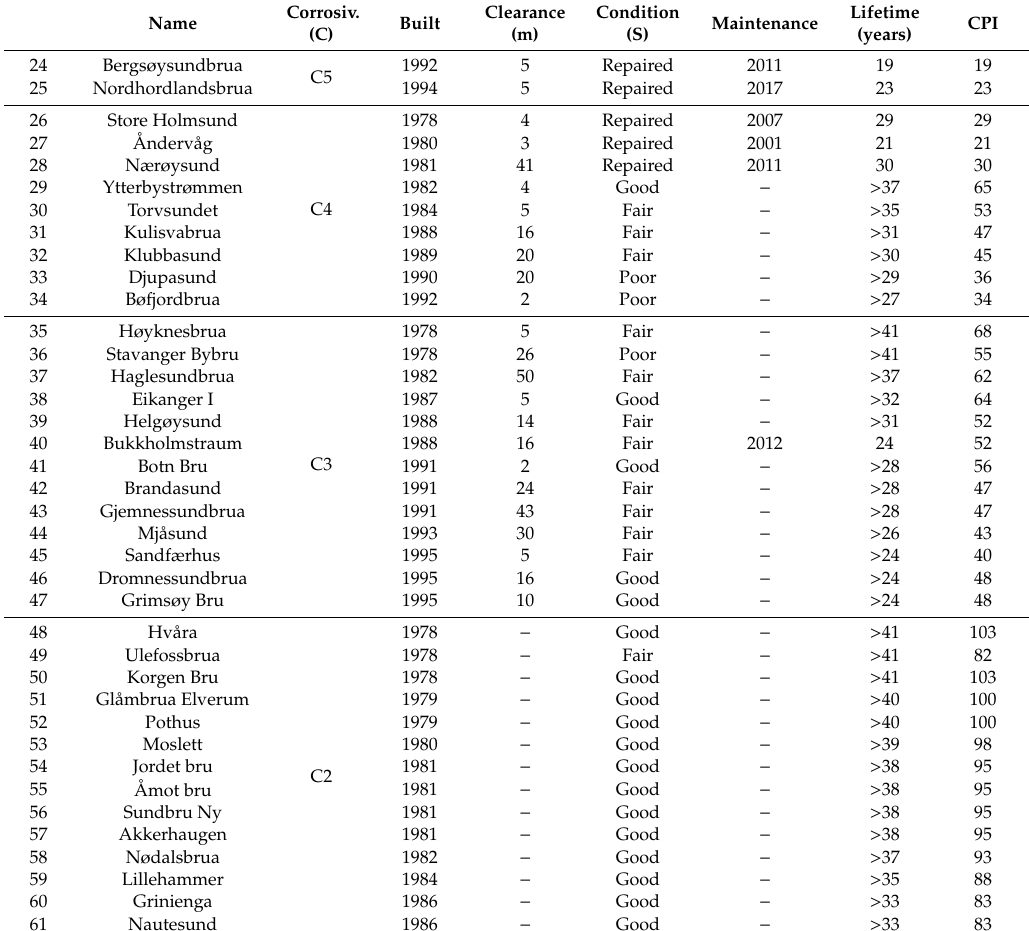
Table 5. The coating lifetime on bridges built between 1978 and 1995. CPI is coating performance